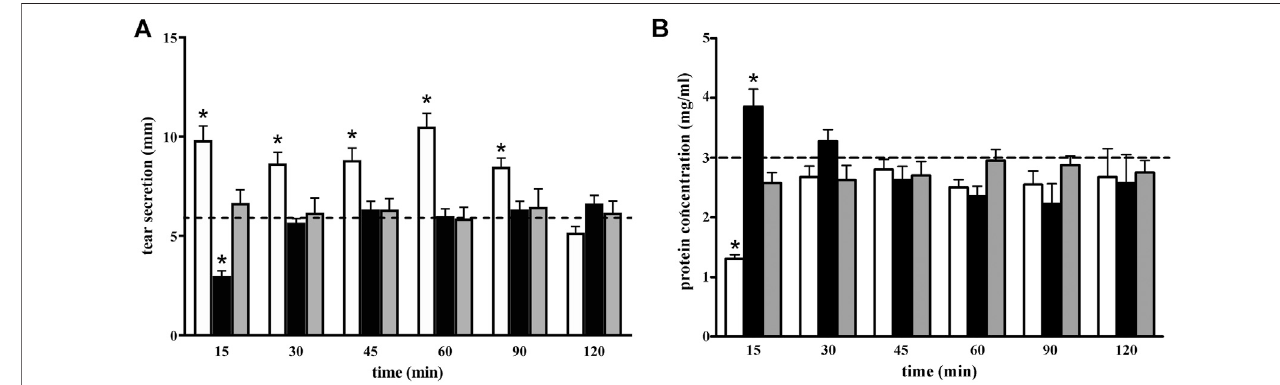
FIGURE3| Longitudinalevaluationofaqueoustearsecretion (A) andtotalproteinconcentration (B) following2%GBT(whitecolumns),0.4%BNX(blackcolumns) or GBT after BNX pretreatment (gray columns). Data are plotted as mean ± SEM. The dotted line indicates the basal value. Differences between groups were tested for statistical signi fi cance using two-way ANOVA with Bonferroni multiple comparison post-test. * p < 0.05 relative to basal ( n (cid:2) 6 eyes).